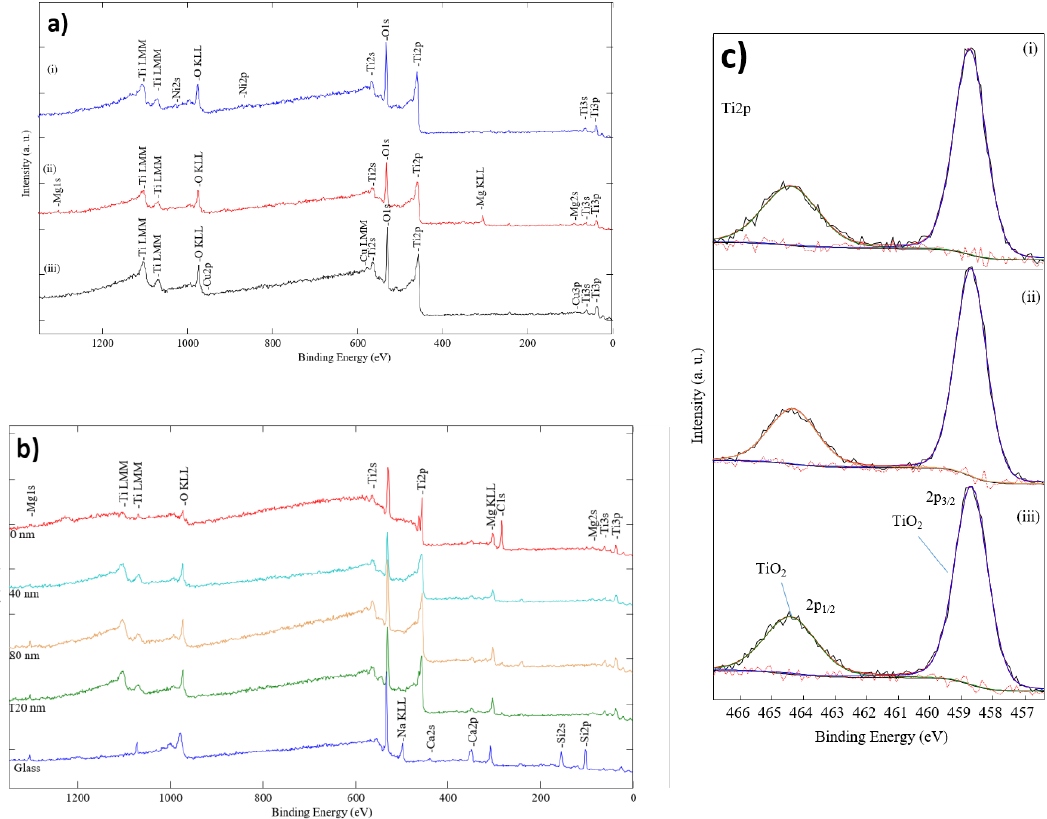
Figure 5. XPS spectra of formed M-doped TiO 2 thin films: a) survey; b) depth profiling of Mg- doped TiO 2 thin films; and c) Ti2p; dopant (i) Ni, (ii) Mg and (iii) Cu. TiO 2 thin films; and ( c ) Ti2p; dopant (i) Ni, (ii) Mg and (iii)